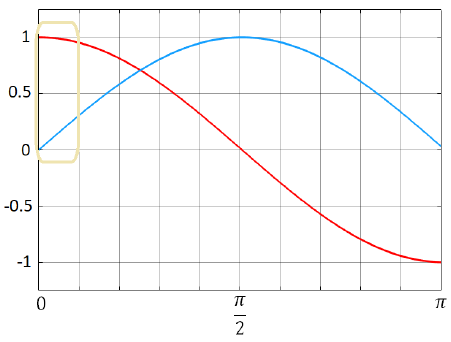
Figure 6. The changes of d and q components on the Park transform output as a function of phase angle. Table 1. The changes of d and q components as a function of the phase angle.